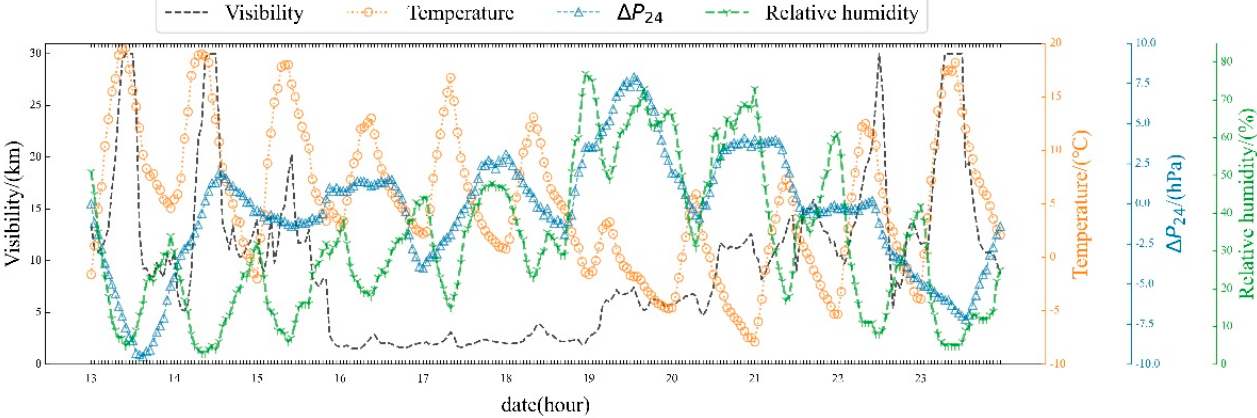
Figure 8. Hourly variation curves of surface temperature, relative humidity, 24-h pressure change, and minimum visibility in Xining City from 13 to 23 March 2021.